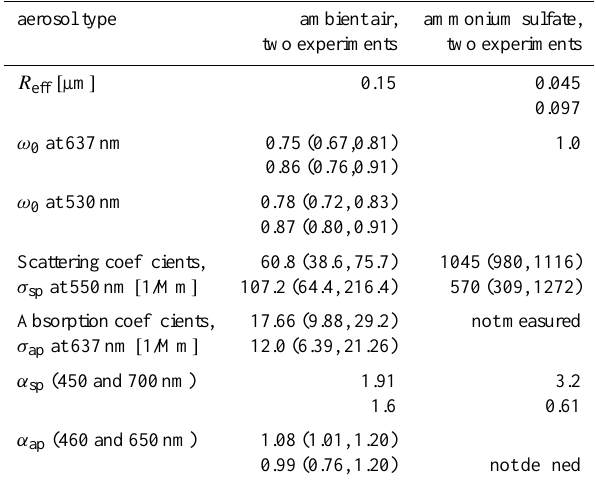
Table 2. Average values of properties of aerosol types used during EUSAAR2007; maximum and minimum values are given between parentheses. For Ammonium sulfate minimum and maximum val- ues are omitted, since single scattering albedo and ˚Angstr¨om expo- nent were very stable during experiments. The optical properties of ammonium sulfate are the same as those given in Table 1 for GAW2005, only the effective radius is